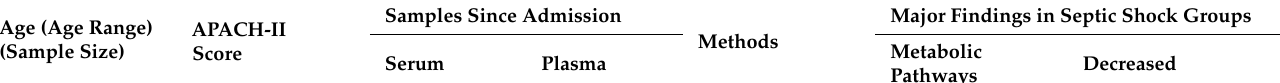
Table 2. Metabolomics-assisted diagnosis of septic shock in critically ill